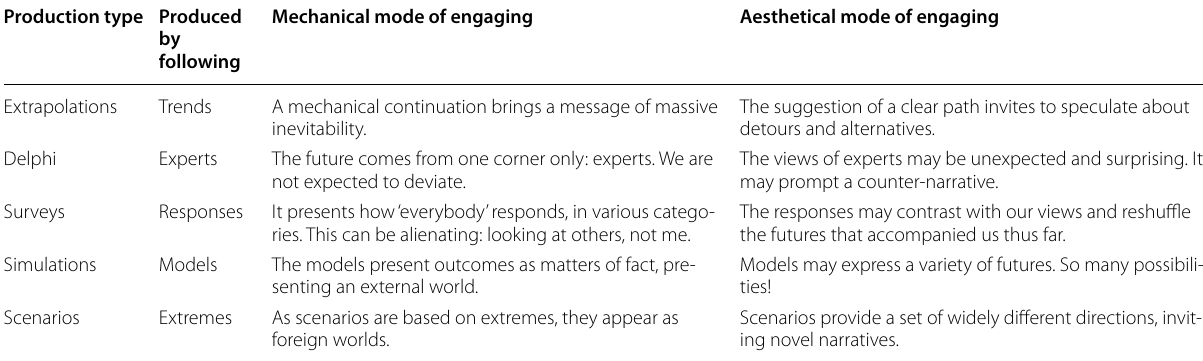
Table 2 Producing futures: mechanical versus aesthetical modes of engaging Production type Produced Mechanical mode of by following